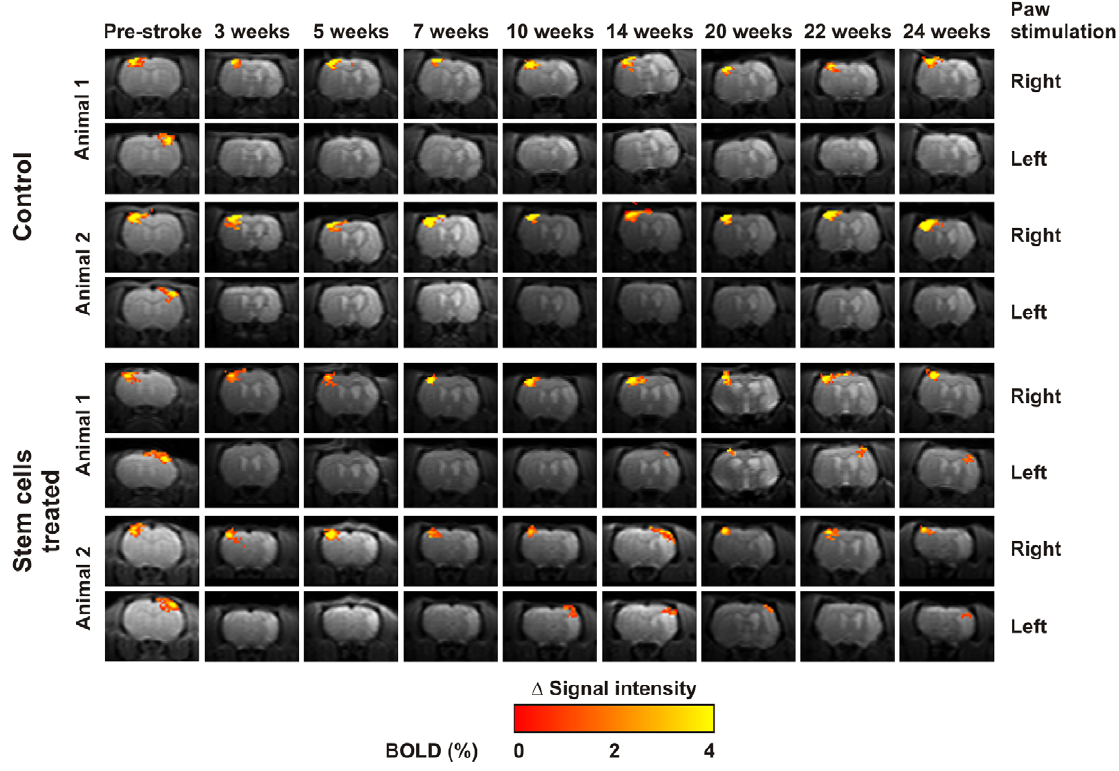
Figure 4. Functional brain recovery during six months observation. BOLD images obtained during the 24 weeks exploration period for two control animals (top rows), presenting a permanent loss of BOLD signal on the affected right hemisphere, and the two stem cell implanted animals (bottom rows) that regained BOLD activity at the affected hemisphere starting from week 10.